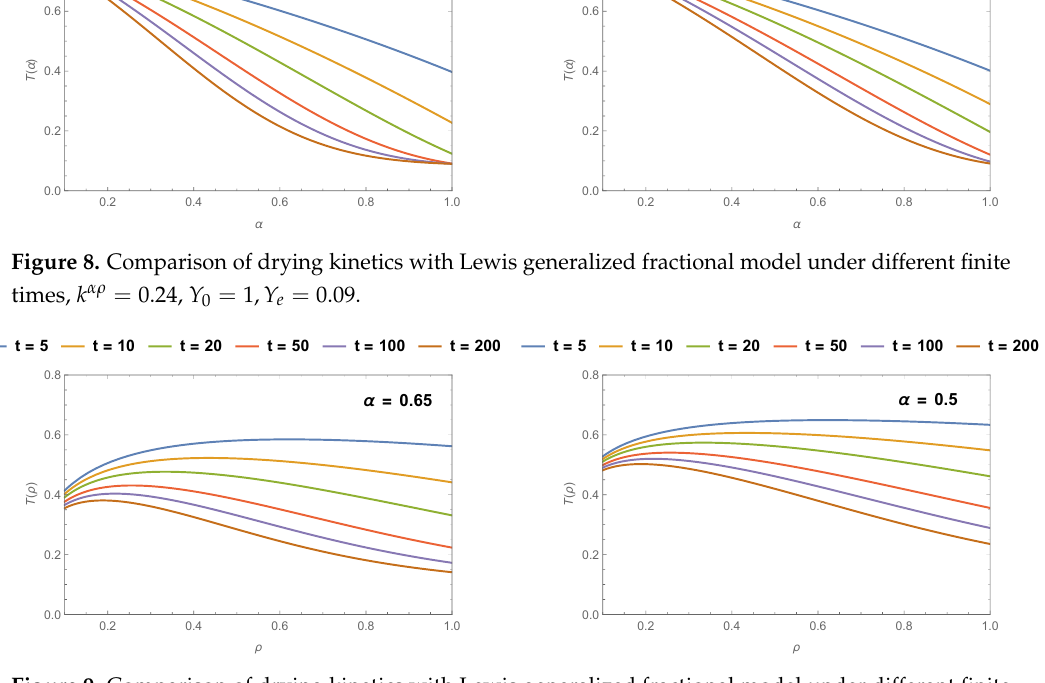
Figure 9. Comparison of drying kinetics with Lewis generalized fractional model under different finite times, k αρ = 0.24, Y 0 = 1, Y e =